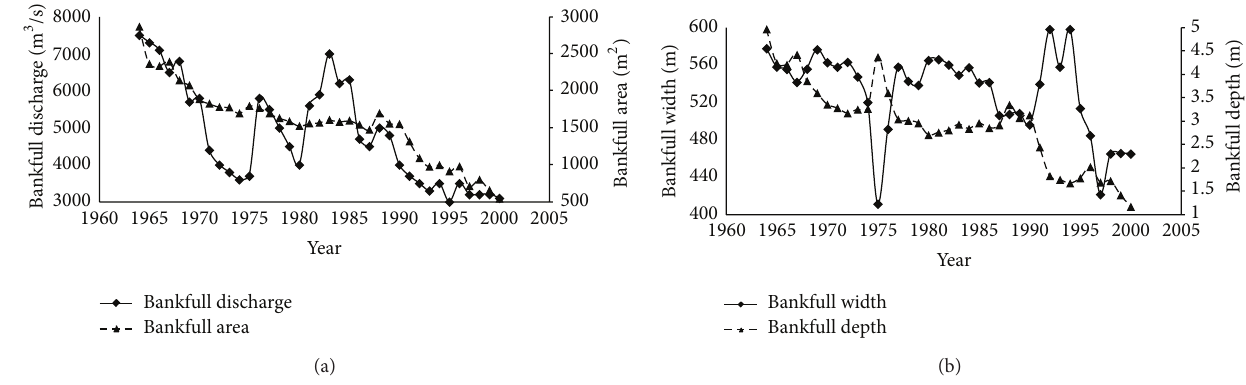
Figure 5: Flow and sediment discharge data at Huayuankou and Lijin Stations.